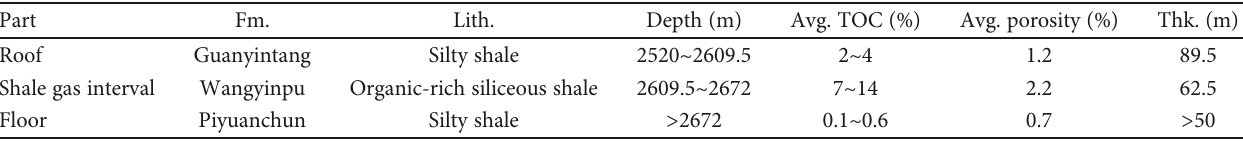
Fm.=formation; Lith.= lithology; Avg.= average; TOC= total organic carbon; Thk.